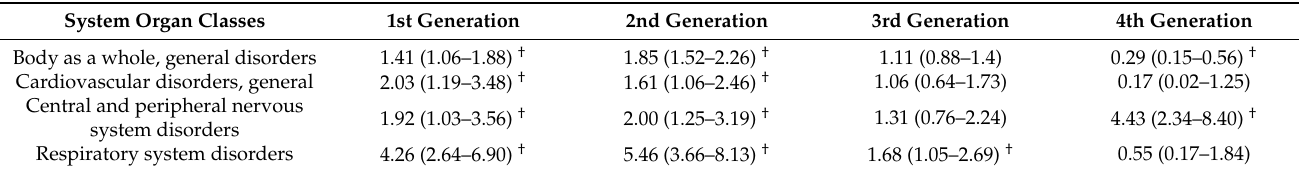
Table 4. ROR (95% CI) of serious AEs by cephalosporin generation: disproportionality analysis compared with all other J01. System Organ